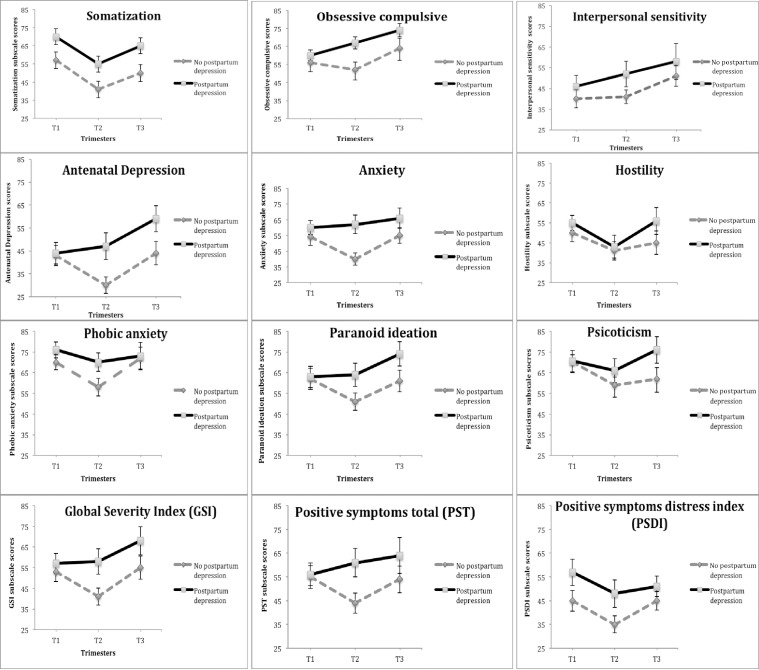
SCL-90-R scores throughout pregnancy in both groups.Note. SOMS = Somatization; OBS = Obsessive-compulsive; SEN = Interpersonal sensitivity; DEP = Depression; ANX = Anxiety; HOS = Hostility; PHOB = Phobic anxiety; PAR = Paranoid ideation; PSI = Psychoticism; GSI = Global severity index; PST = Positive symptoms total; PSDI = Positive symptoms distress index; PPD = Postpartum depression; NO PPD = No postpartum depression.